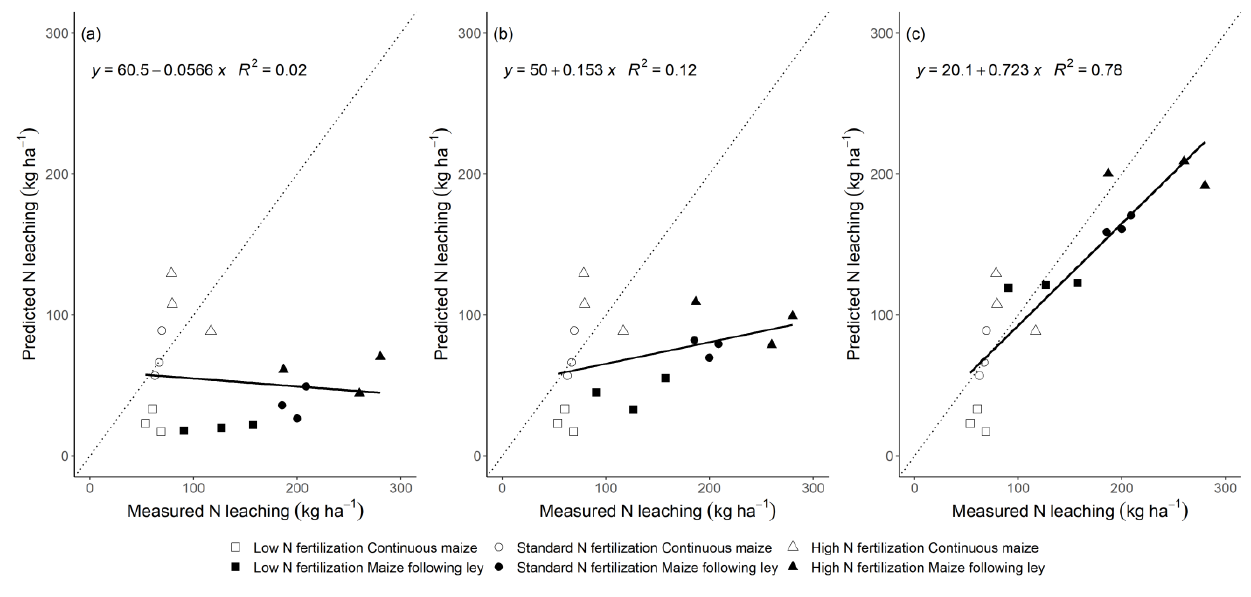
Figure 5. Measured and APSIM predicted nitrogen (N) leaching in experimental site 2, for the low, standard, and high N fertilization levels. Results are shown for the generic approach accounting for aboveground residues ( a ), above- and belowground residues ( b ), and the simple mineralization model ( c ) (see Figure 1). Table 7. Performance statistics for annual nitrogen leaching (n = 7) for experimental site 3; R 2 = co-